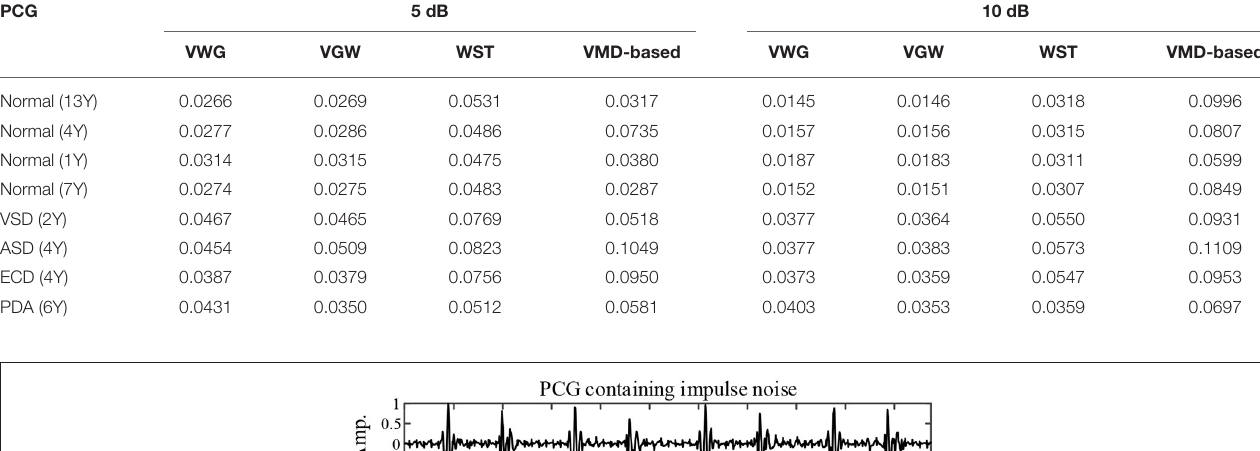
TABLE 3 | Comparison of root mean square error (RMSE) of PCG signals with Gaussian noise after noise reduction. PCG 5